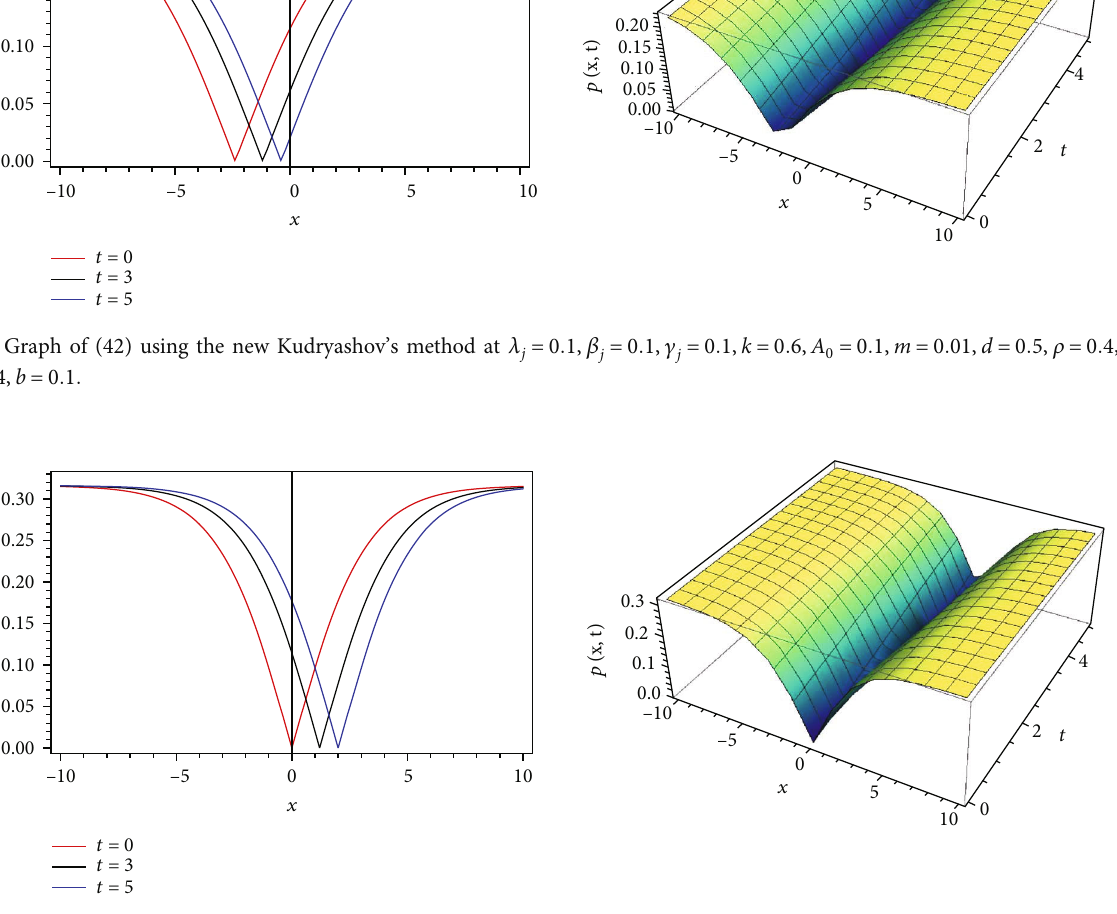
Figure 5: Graph of (47) using the extended tanh-function method at λ